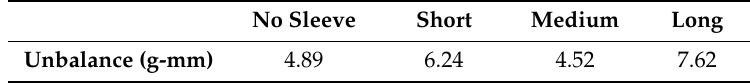
Table 3. Residual unbalance in test shaft/sleeve configurations.